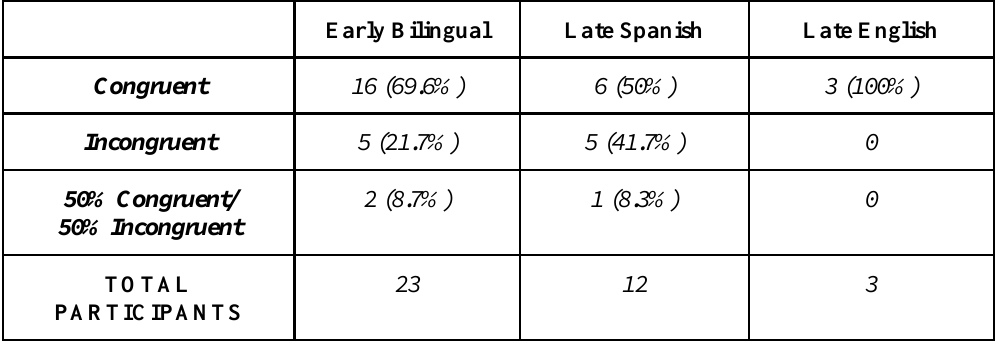
Table 6. Congruency percentages for bilingual groups (Stimuli with Spanish feminine translation